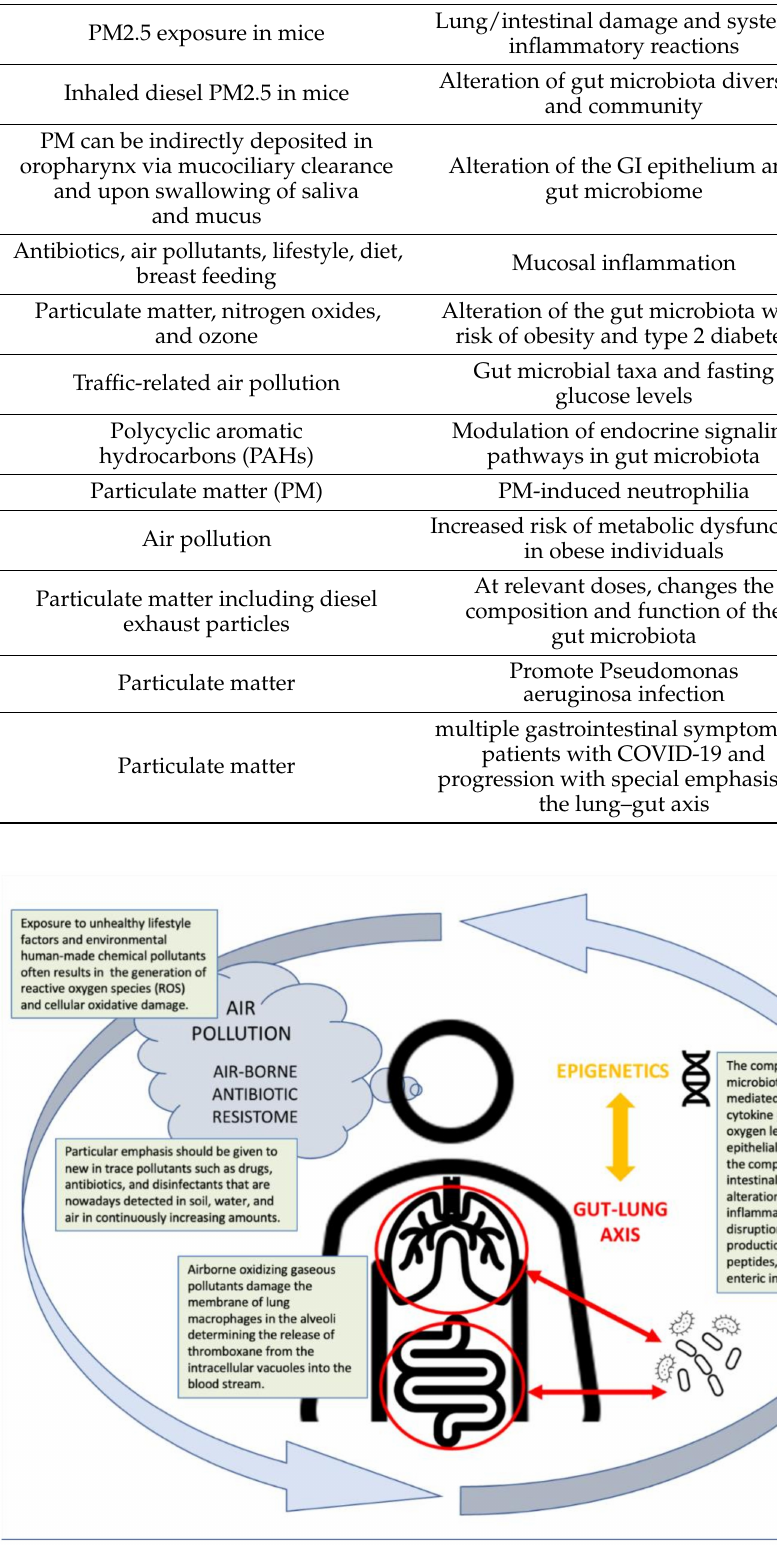
Figure 1. How the environment affects the lung–gut axis of